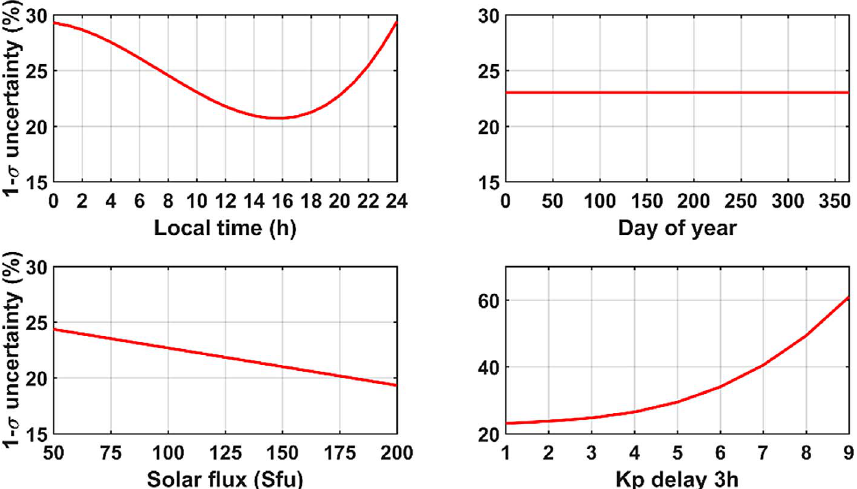
Fig. 5. 1- r uncertainty (in percent) least-square fi tting: (top-left) 1- r uncertainty as a function of local time, (top-right) 1- r uncertainty as a function of day of the year, (bottom-left) 1- r uncertainty as a function of solar fl ux, (bottom-right) 1- r uncertainty as a function of K p